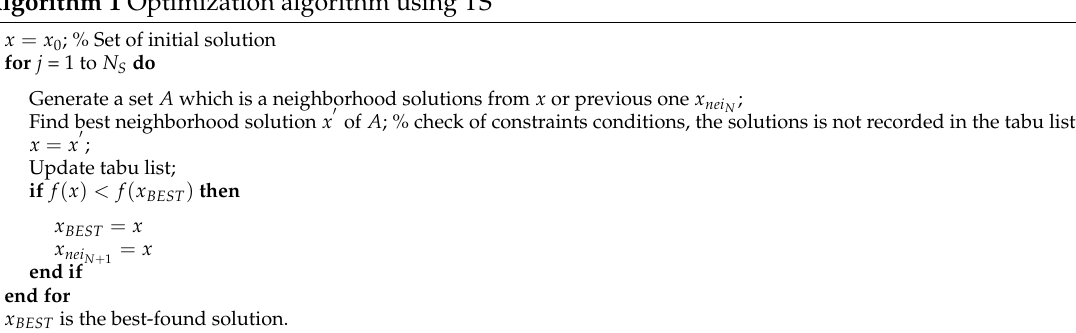
Algorithm 1 Optimization algorithm using